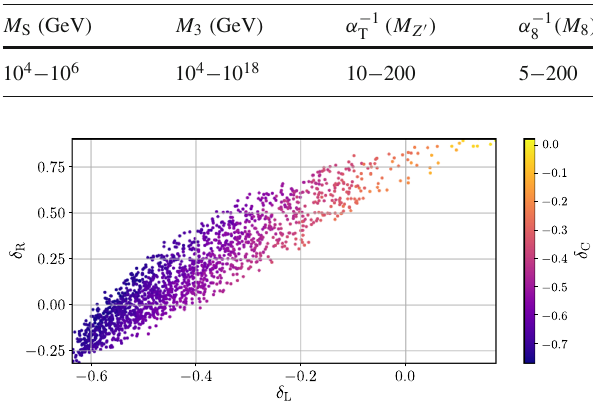
Fig. 8 Possible values for the non-universality factors δ L , δ R and δ C